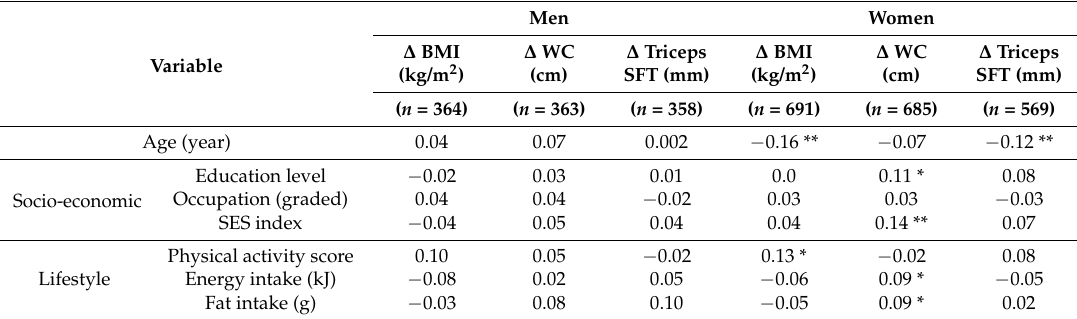
Table 3. Spearman correlations between changes in adiposity and baseline dietary intake, socio-economic, and lifestyle variables.